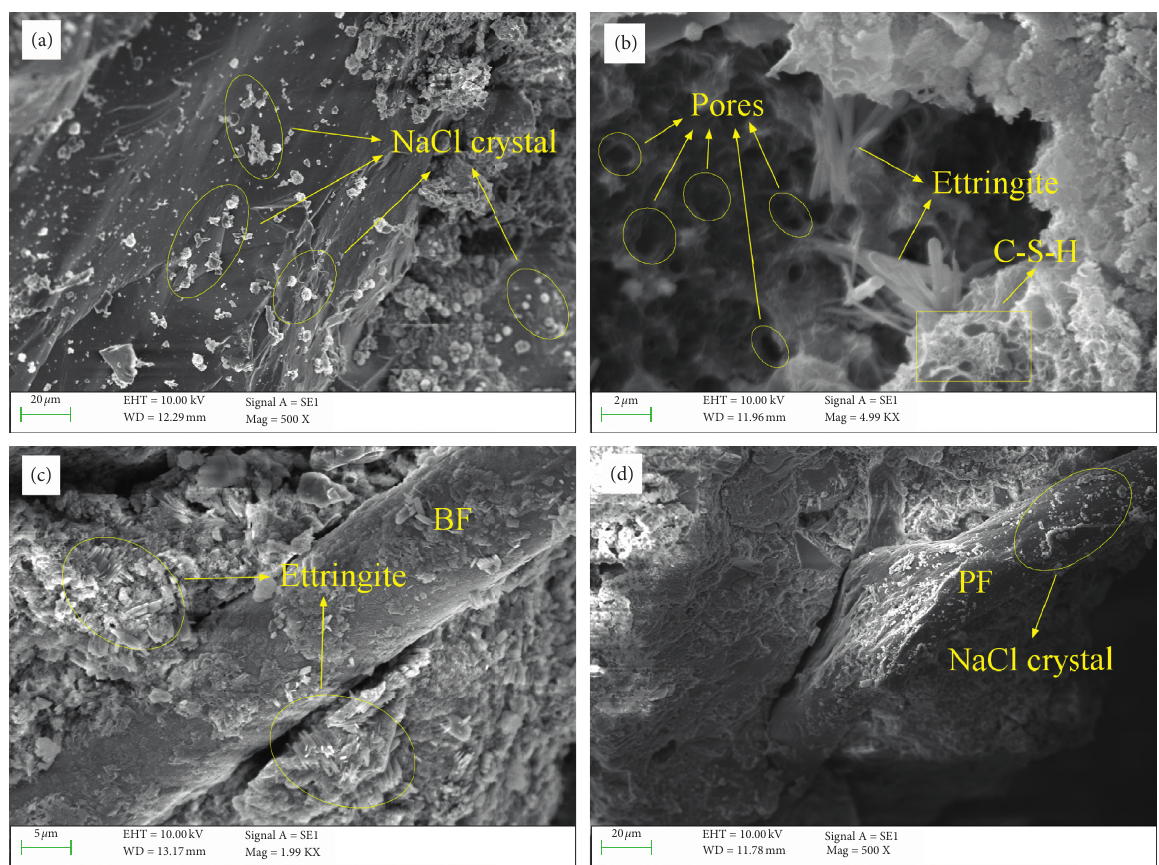
Figure 17: FE-SEM micrographs of BPC-40-0.1 concrete after 180 days of exposure time. (a) Sodium chloride crystals. (b) Corrosion products. (c) The interface between the BF and concrete matrix. (d) The interface between the PF and concrete